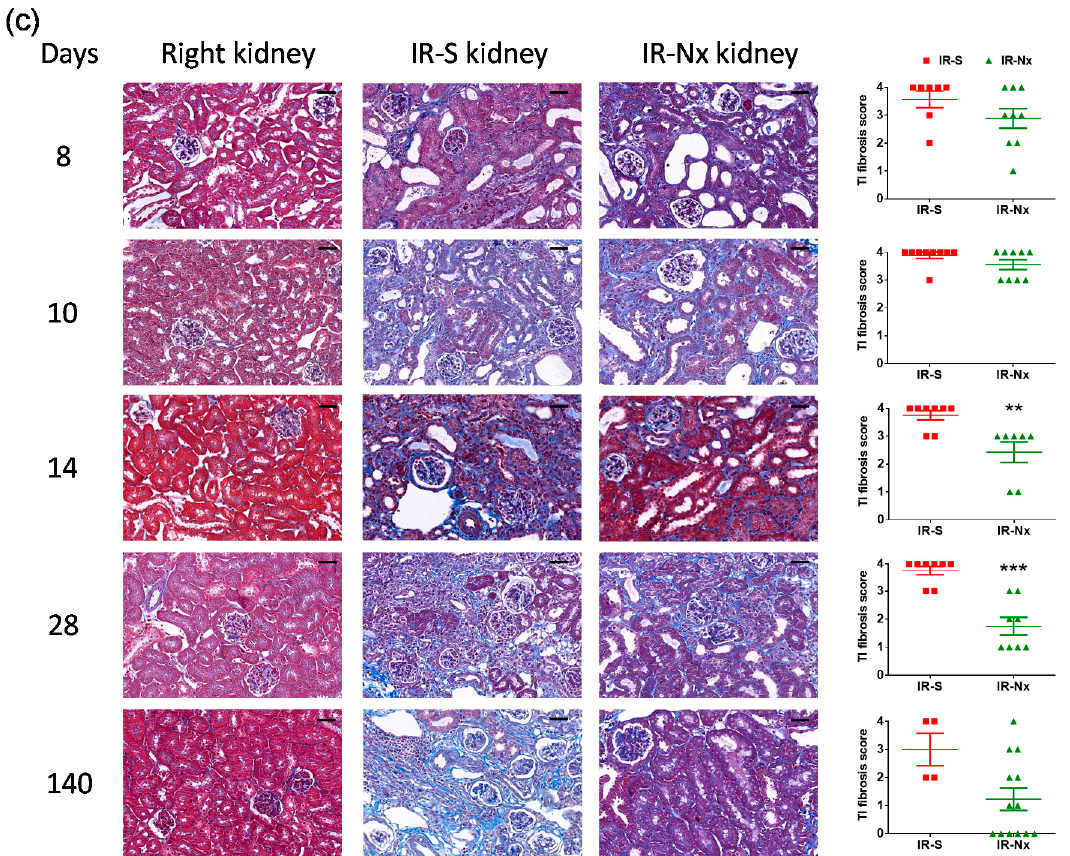
Figure 4. Kidney morphology. Representative pictures of nonischemic right (left column), postischemic left kidneys in the IR-S (middle histology column) and IR-Nx (right histology column) groups and the histology scores (right column). ( a ) Macroscopic picture of a nonischemic right and a pale, fibrotic / atrophic (postischemic) left kidney in the IR-S group on day 28 in situ. ( b ) PAS-stained sections (800 × , scale bar: 50 µ m) and tubular injury (TI) scores (0–4) ( c ) Masson’s trichrome-stained sections (800 × , scale bar: 50 µ m) and the tubulointerstitial (TI) fibrosis scores (0–4). Data are expressed as mean ± SEM; unpaired, nonparametrical Mann-Whitney t -test. *: p < 0.05, **: p < 0.01 and ***: p < 0.001 between the IR-S (red) vs. IR-Nx (green) groups.